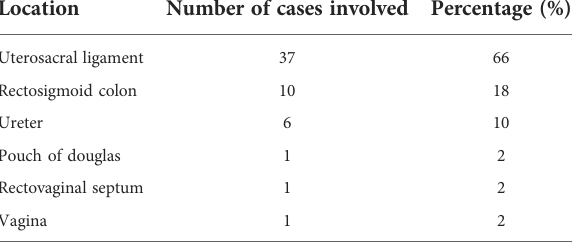
TABLE 3 The description of the locations of the DE